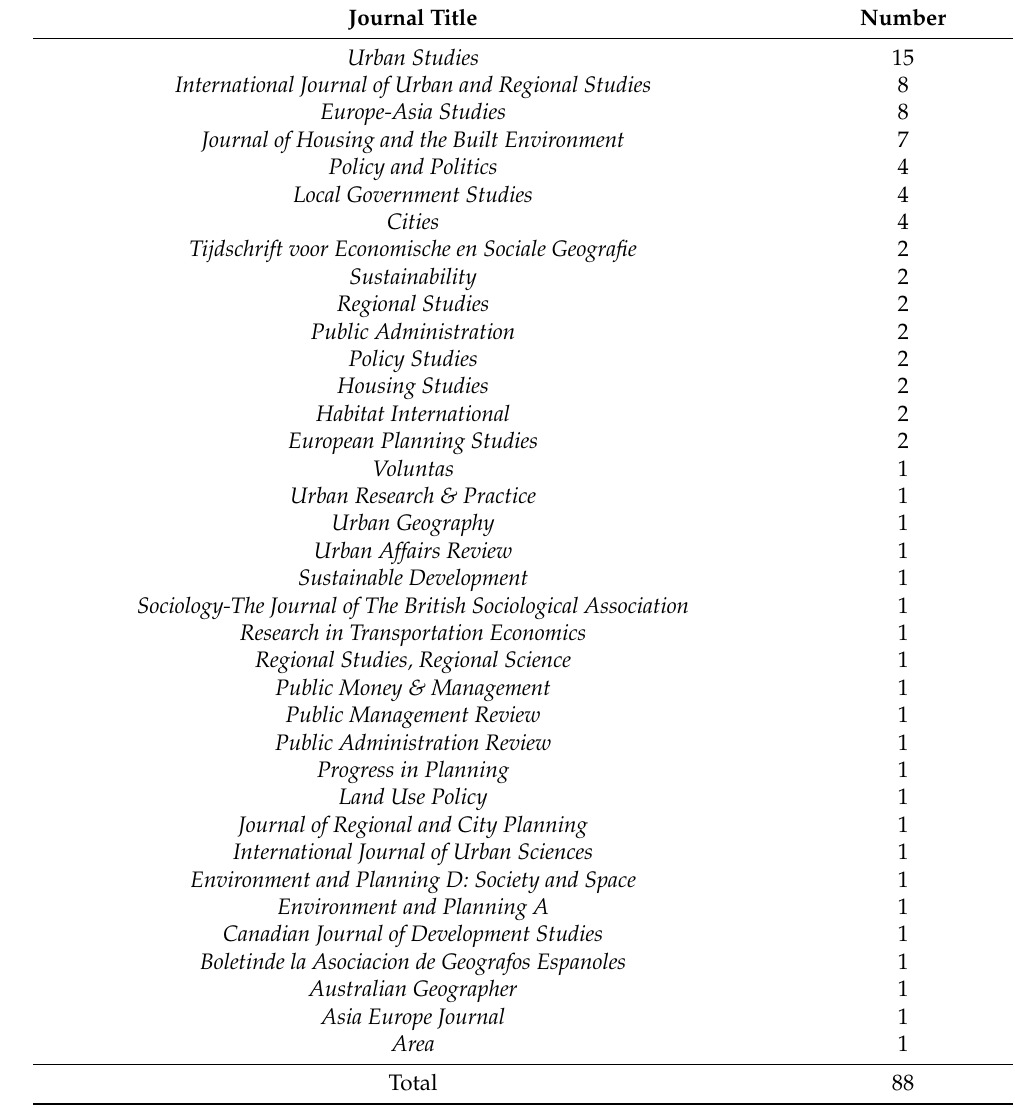
Table 1. The journals and the number of corresponding